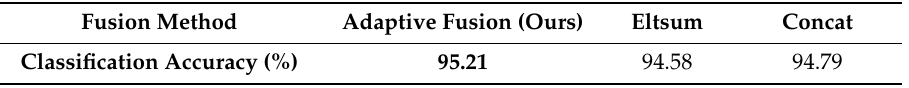
Table 4. Comparison between di ff erent fusion methods on the Google dataset of